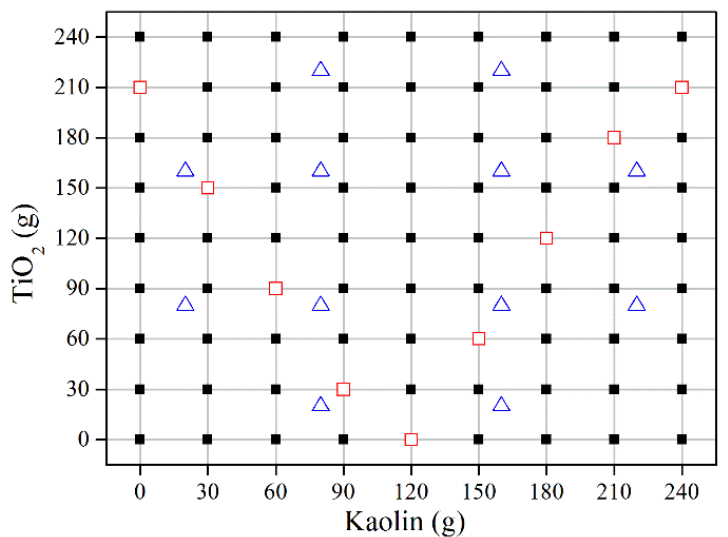
Figure 3. The experimental design of the samples: the black solid squares represent the training subset; the red hollow squares stand for the prediction subset; the blue triangles denote the inline test